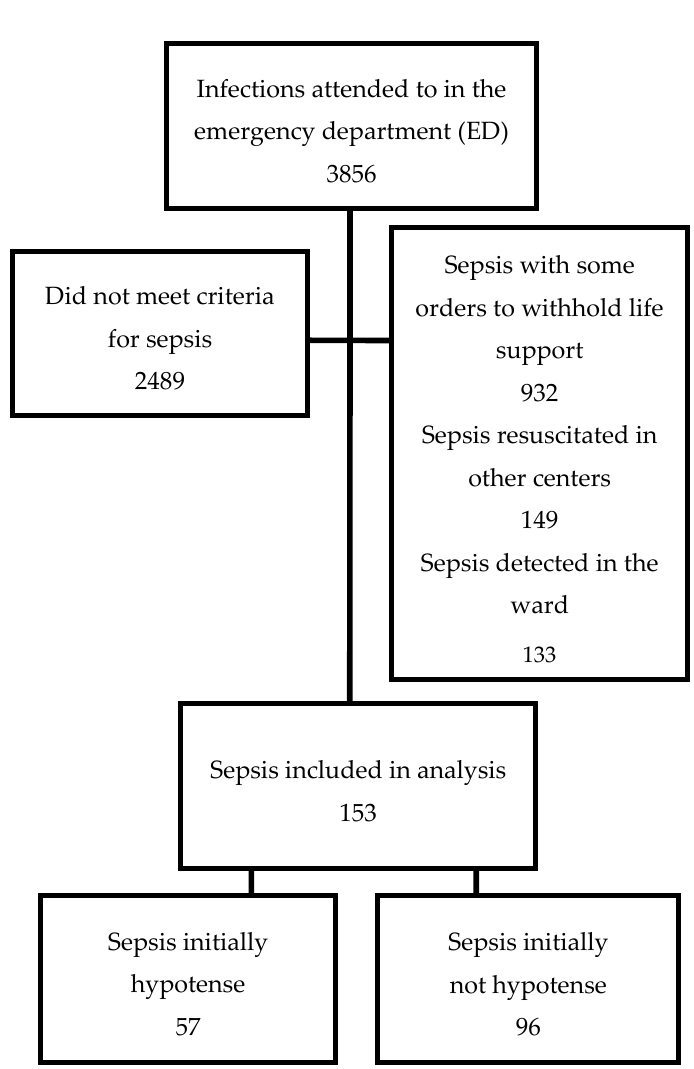
Figure 2. Enrollment flow chart.